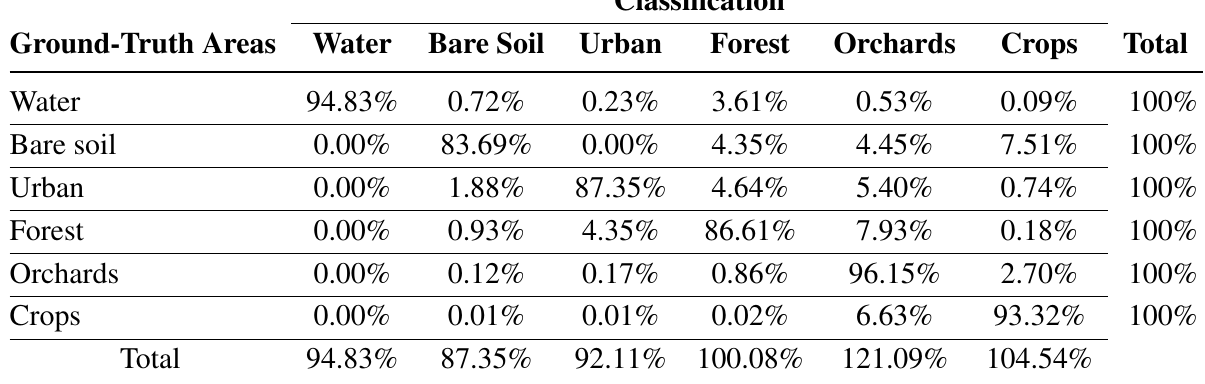
Table 5. Confusion matrix showing results of the classification of the final map. The values are expressed on percentages of overlapping area between ground-truth regions and the final